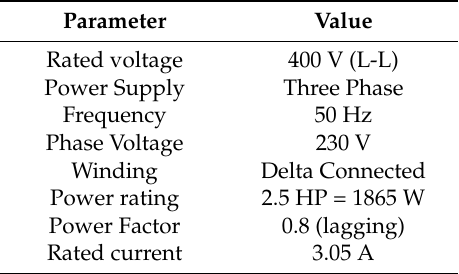
Table 1. Designed ratings and parameters of the proposed multifunctional induction machine (IM).